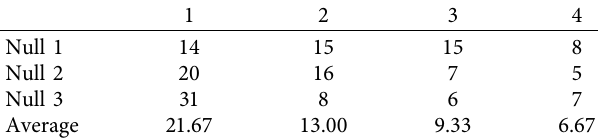
Figure 19: Azimuth cut of the normalized power pattern (at the elevation angle of 35 degrees) in a decibel scale. Te radius values are wavelength-normalized. Table 16: Null depth (in dB) corresponding to null steering at radii 1, 2, 3, and 4 (wavelength-normalized). SD denotes standard deviation.